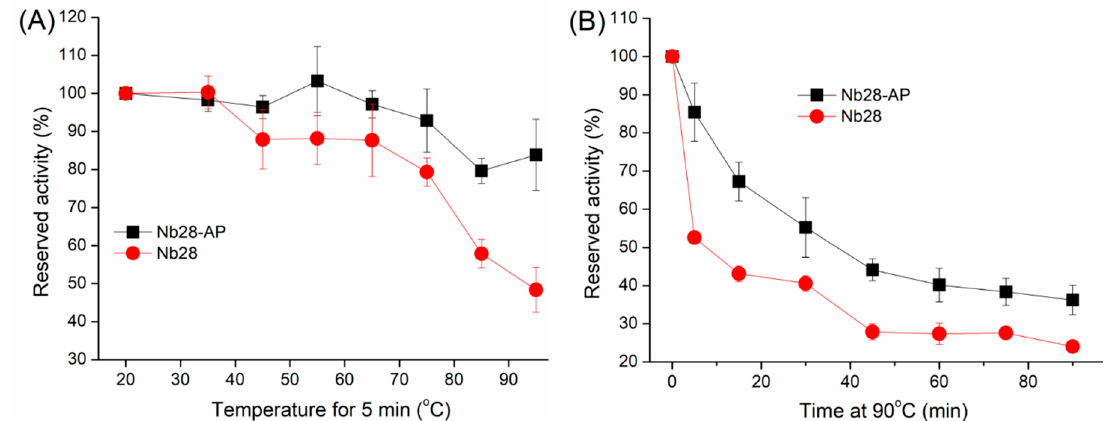
Figure 2. Thermal stability of Nb28 and Nb28-AP. Nb28 and Nb28-AP at working concontrations were incubated at serial temperatures (35, 45, 55, 65, 75, 85, 95 °C) for 5 min ( A ) or at 90 °C for various lengths of time (0, 5, 15, 30, 45, 60, 75 min) ( B ). After cooling to room temperature, the reserved activity of Nb28 and Nb28-AP was measured by an indirect ELISA. The error bars represent the standard deviation of three independent tests.